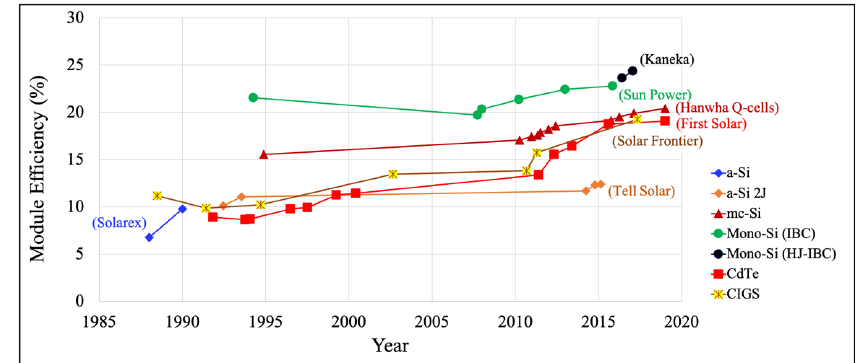
Figure 5. History of the development of the champion module efficiencies for terrestrial technologies plotted from 1988 to the present. For each technology is reported the manufacturer of the module that holds the world efficiency record. Acronym explanation: a-Si 2J = amorphous silicon double-junction cells, mc-Si = multicrystalline silicon, mono-Si (IBC) = single-crystal silicon with interdigitated back contacts, mono-Si (HJ-IBC) = single-crystal silicon with amorphous silicon heterojunction contacts made on the back of the cell. Data reported from https://www.nrel.gov/pv/module-efficiency.html.